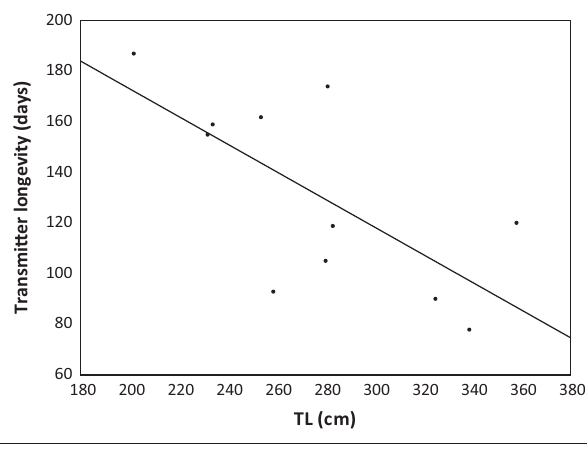
FIGURE 2: Scatter plot showing the relationship between transmitter attachment longevity and total length of Nile crocodiles at Ndumo Game